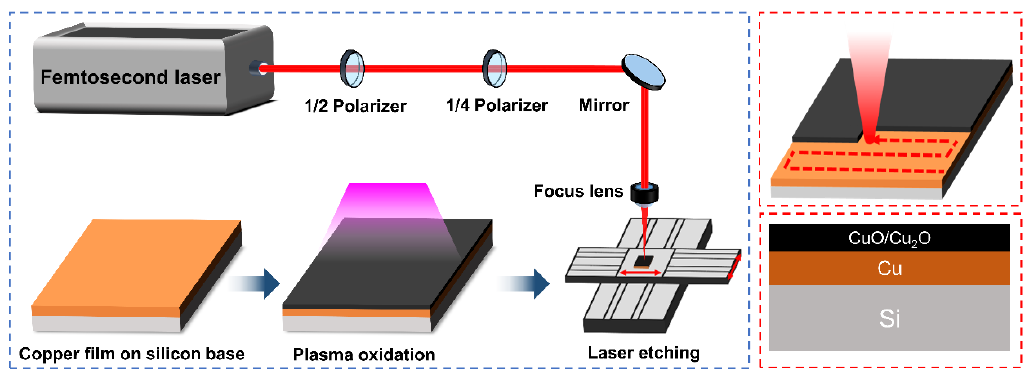
Figure 1. Schematic diagram of experimental program.